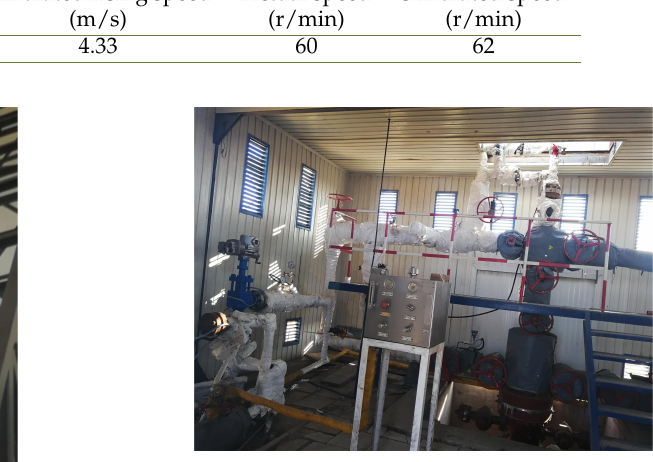
Fig. 18. Installation drawing of wellhead control equipment.